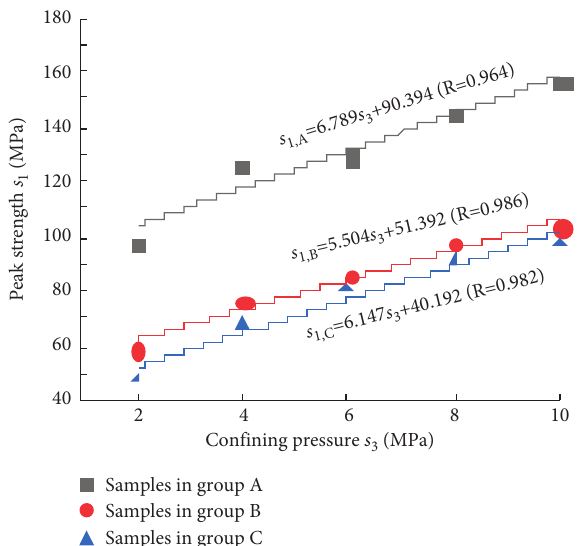
Figure 4: Relationship between peak strength and confining pressure of the three group